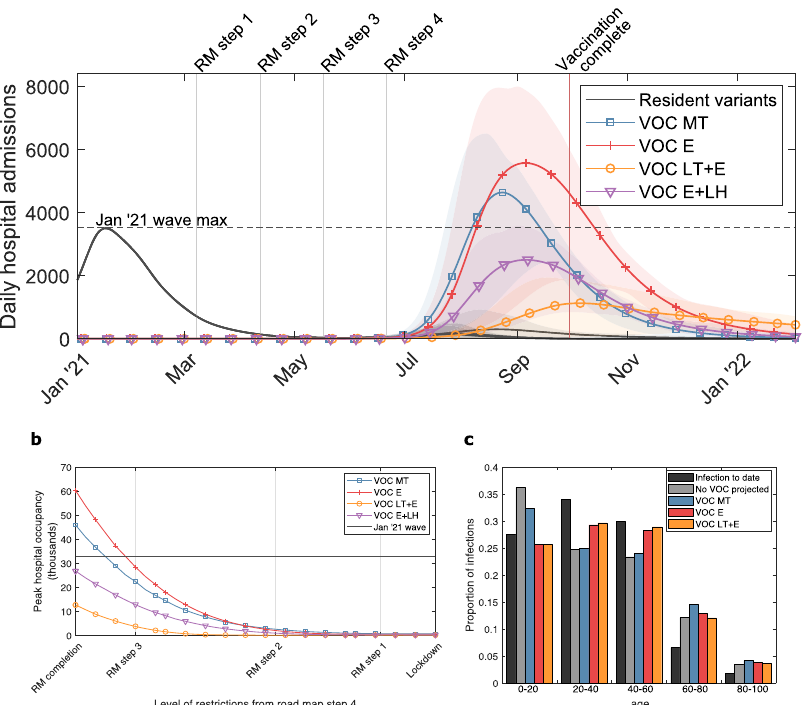
Fig. 2 Estimated COVID-19 hospitalisations, using the age-structured SARS-CoV-2 transmission model, across the illustrative variant-of-concern (VOC) scenarios. We considered four putative VOCs with differing transmissibility, severity, and immune-escape characteristics: more transmissible (VOC MT, blue, square markers), equal transmissibility with immune escape (VOC E, orange, plus-sign markers), less transmissible with immune escape (VOC LT + E, yellow, circle markers), and equal transmissibility with the same immune-escape properties of VOC E with the exception of a lesser reduction in vaccine-derived ef fi cacy against hospitalisation (VOC E + LH, purple, inverted triangle markers). a Time series of daily hospital admissions (thousands). Solid lines show the mean at each timepoint and the shaded ribbons the 95% prediction intervals. The dashed horizontal line denotes the peak in daily hospital admissions in England during the January 2021 wave. Vertical grey lines give the timing of each Step of the relaxation roadmap (RM), with Step 4 being placed at the earliest stipulated date that it may begin (21st June 2021). The vertical light-red line corresponds to the projected date under our vaccine roll-out speed assumption where all those in the adult population (18 + years of age) in England who accept the vaccine would have received two doses. b Relationship between mean peak hospital occupancy with VOC (thousands) and the level of NPIs toward the population following Step 4 of the relaxation roadmap. c Age distribution of infections from the historical data up to May 2021 (black bars) alongside the projected distributions for the resident variant in the absence of any VOCs (grey bars) and each VOC scenario (VOC MT: blue bars; VOC E: red bars; VOC LT + E: orange grey bars vs black bars). Such effects were reduced for a VOC with increased transmission (e.g., VOC MT, blue bars), as it is expected to cause an earlier surge in cases at a time when the vaccination programme is less advanced. VOCs with immune- escape characteristics (VOC E, orange bars, and VOC LT + E, yellow bars) were less affected by both previous infection and vaccination, resulting in an age distribution of infection that more closely matched the historical pro fi le. Nonetheless, if the roadmap is run to completion, the more relaxed levels of NPIs than have been previously seen are still expected to cause signi fi cantly